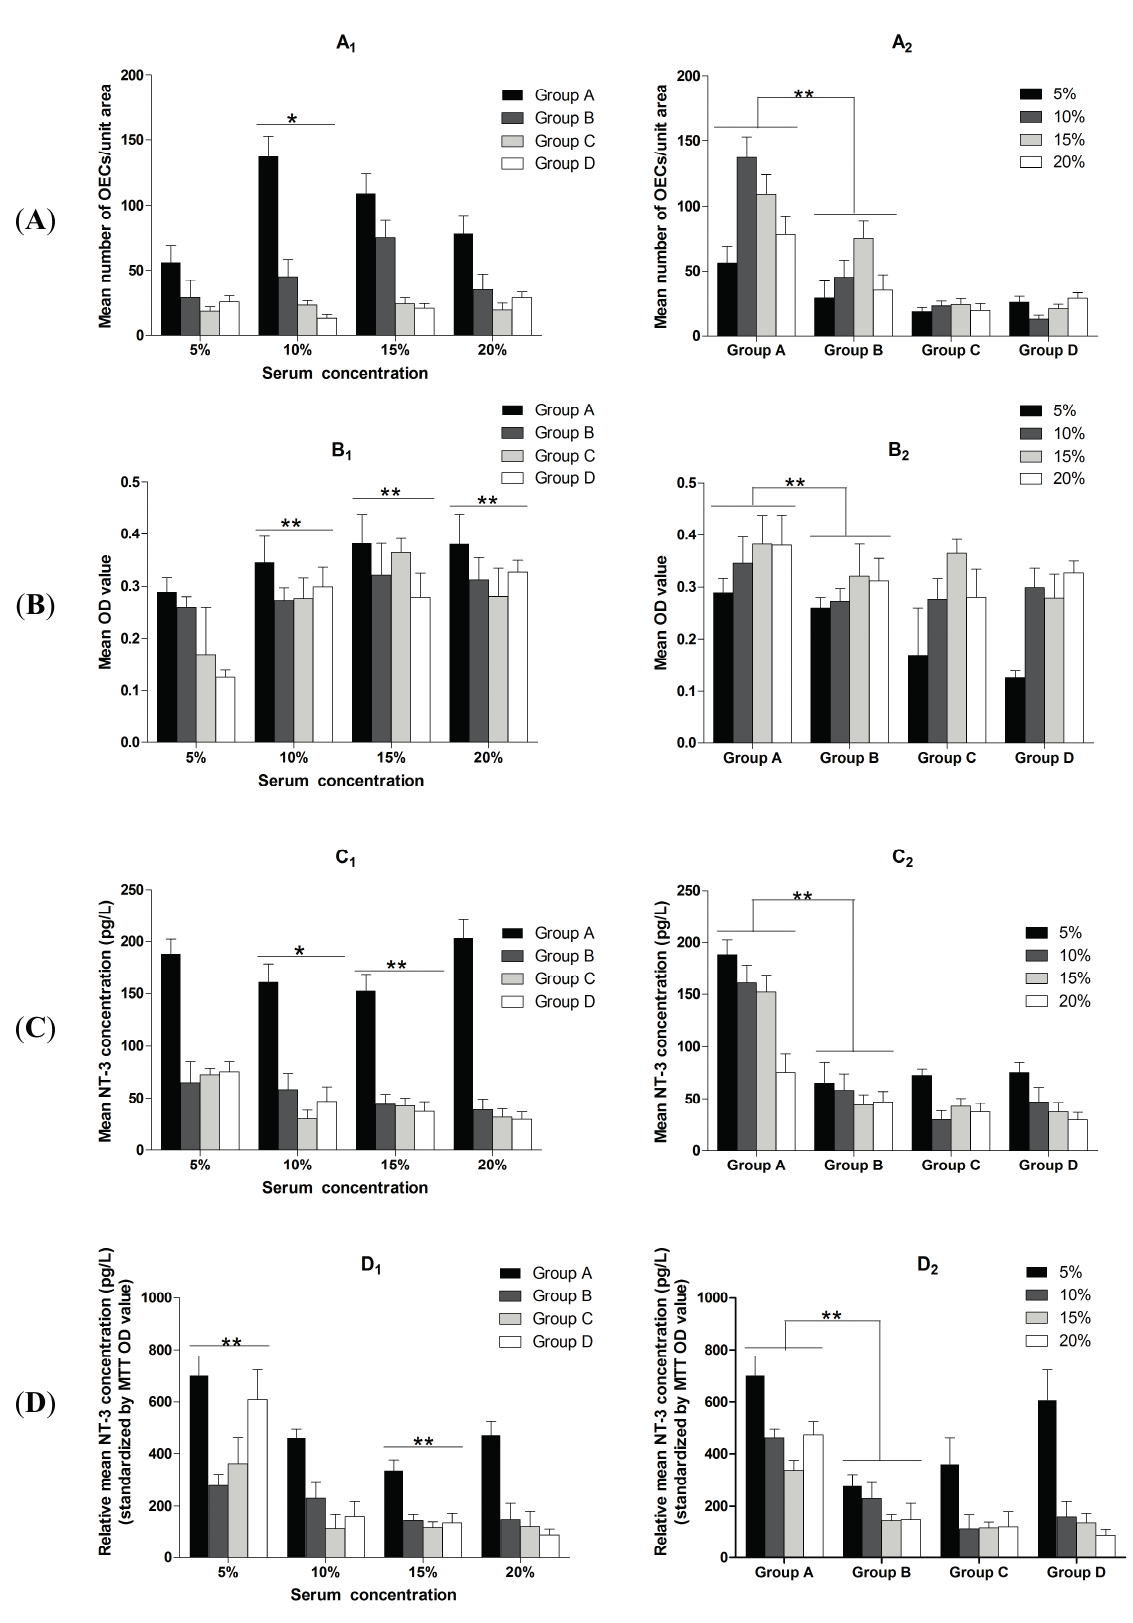
Figure 6. MTT assay and P75 neurotrophin receptor immunofluorescence staining were used to examine cell viability and OEC numbers, respectively. The concentration of NT-3 in the culture supernatant was detected by ELISA. Results which are analyzed according to different culture process at the same serum concentration are shown in A